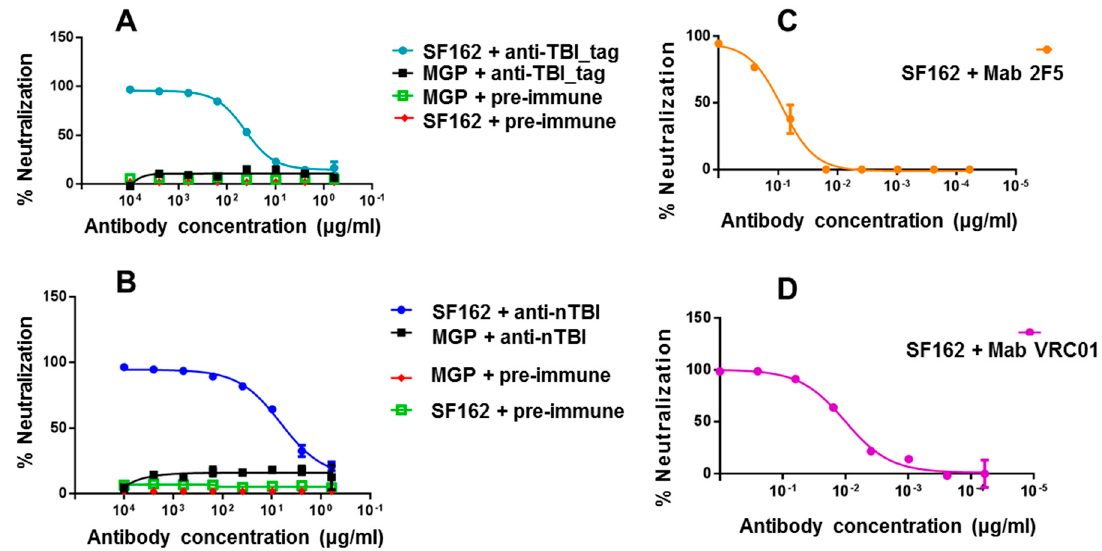
Figure 6. Neutralizing activity of IgGs isolated from sera of immunized animals against SF162.LS pseudovirus. The figure depicts neutralization curves for anti-TBI_tag ( A ), anti-nTBI ( B) rabbit IgGs, as well as for human mAbs 2F5 ( C ) and VRC01 ( D ). 2F5 and VRC01 were used as positive controls. A pool of IgGs purified from pre-immune sera of rabbits (IgGs-pre-immune) was used as a negative control. Lentiviral particles pseudotyped with Marburg envelope glycoprotein (MGP) were used as a specificity control virus in the neutralization